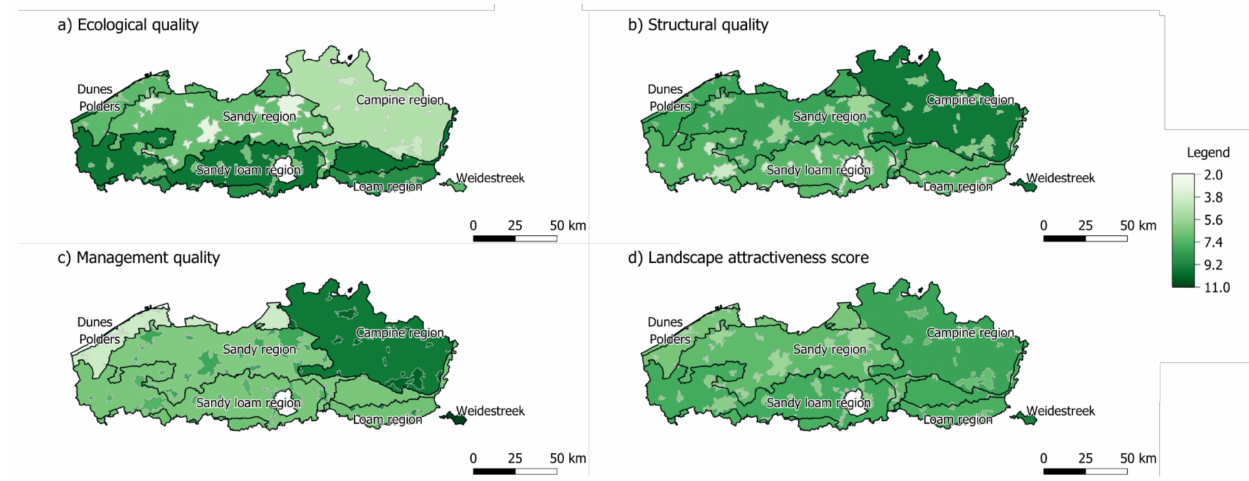
Figure 6. ( a ) Ecological quality score map, ( b ) Structural quality score map, ( c ) Management quality score map and ( d ) overall landscape attractiveness score map. Indices were calculated for the urban and rural area in each agricultural region. Agricultural regions were delineated with a black line, urban regions with a grey line. Darker green regions have a higher scoring on the considered landscape attractiveness